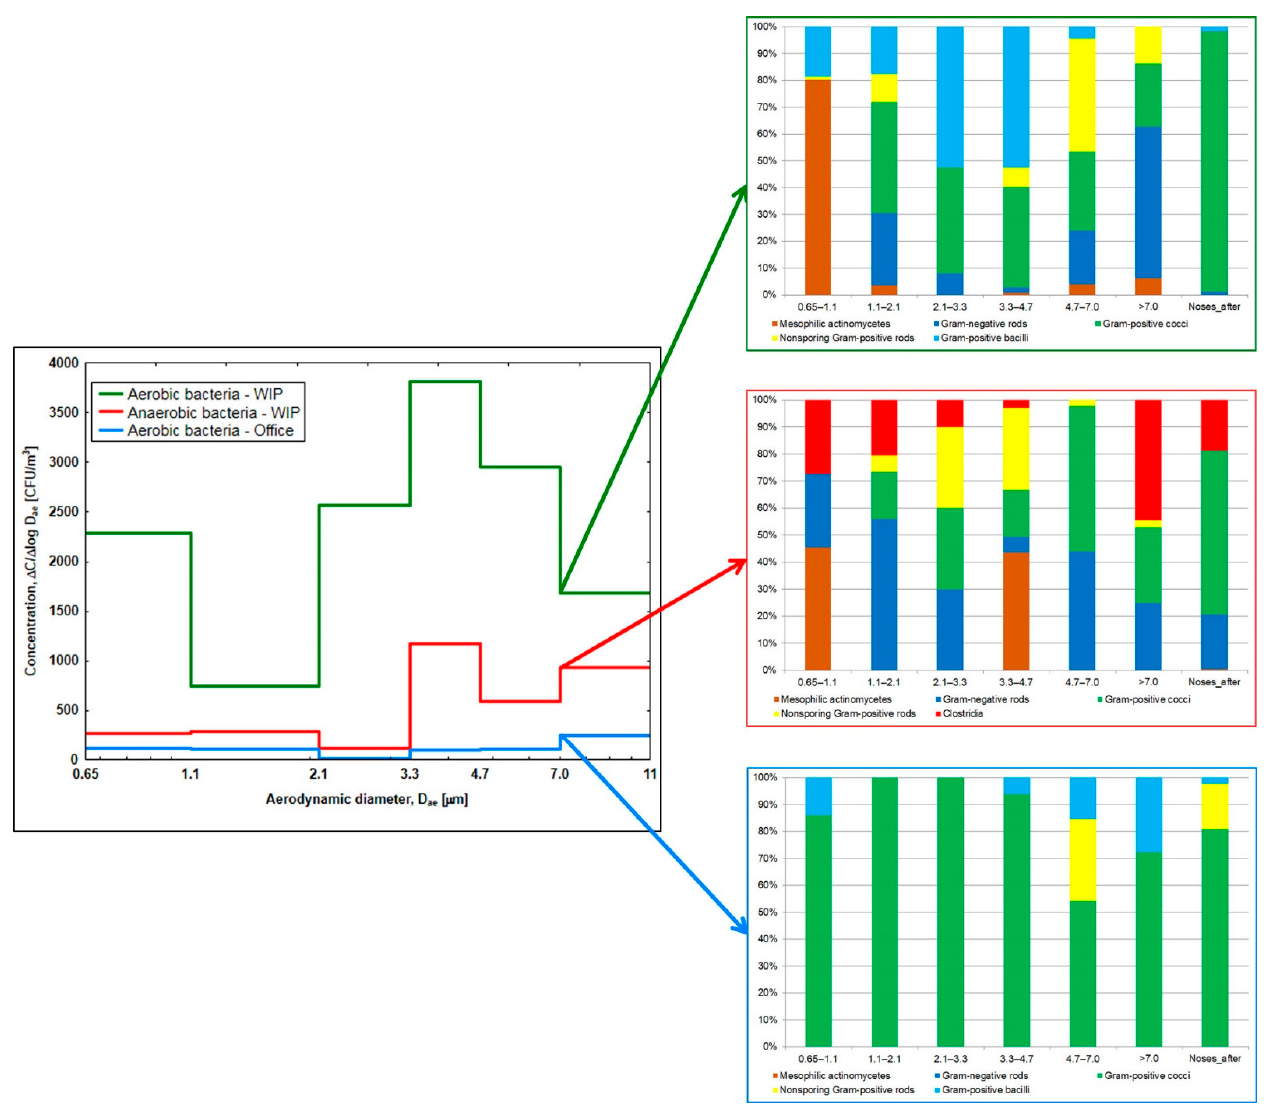
Figure 2. Size distribution analysis of bacterial aerosols in waste incineration plant (WIP) and office